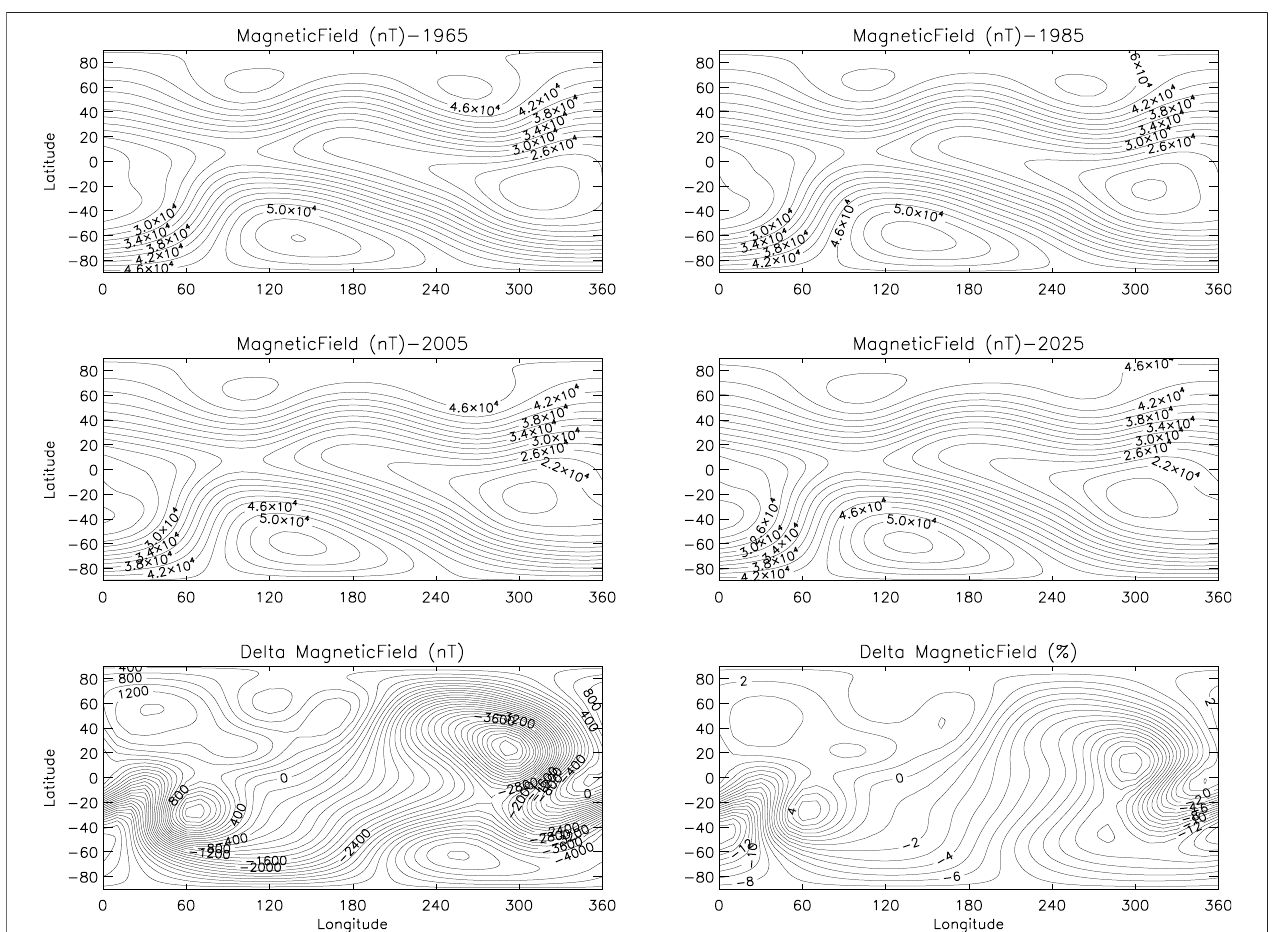
FIGURE1| Contour ofthebackgroundmagnetic fi eldcalculated bytheIGRF13modelfrom1965to2025byevery20 yearsand absoluteandrelativechangesof the magnetic fi eld contour image.